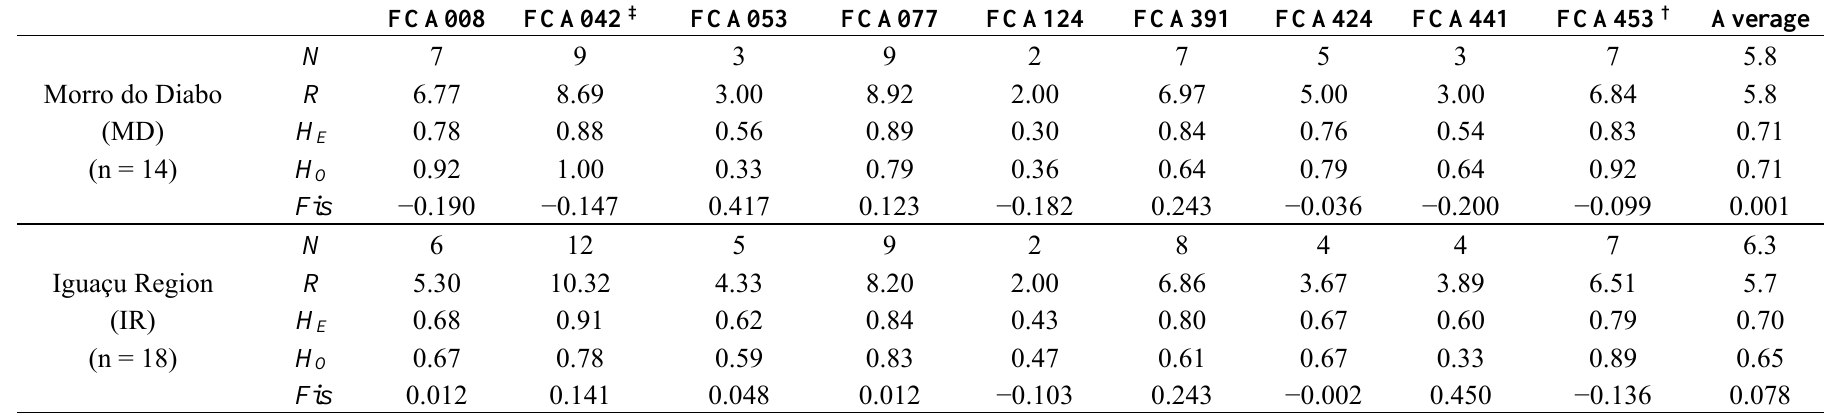
Table 1. Genetic diversity at nine microsatellite loci for Leopardus pardalis sampled at the two areas investigated in this study